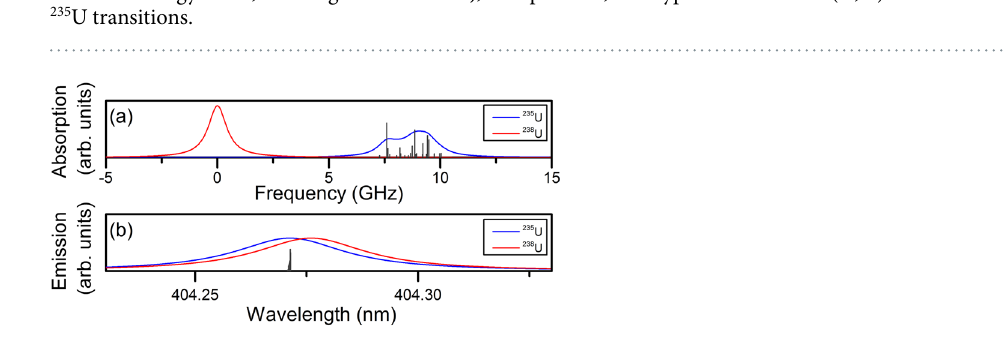
Figure 7. Modeled absorption and emission spectra including hyperfine structure for 235 U (blue) and 238 U (red). The total area of the peaks are equal for the 238 U and 235 U transitions. Relative strengths of individual hyperfine transitions are also shown. ( a ) Absorption spectrum for U I 394.38 nm where each transition is a Lorentzian with 1 GHz FWHM. ( b ) Emission spectrum for U I 404.28 nm where each transition is a Lorentzian with 30 pm